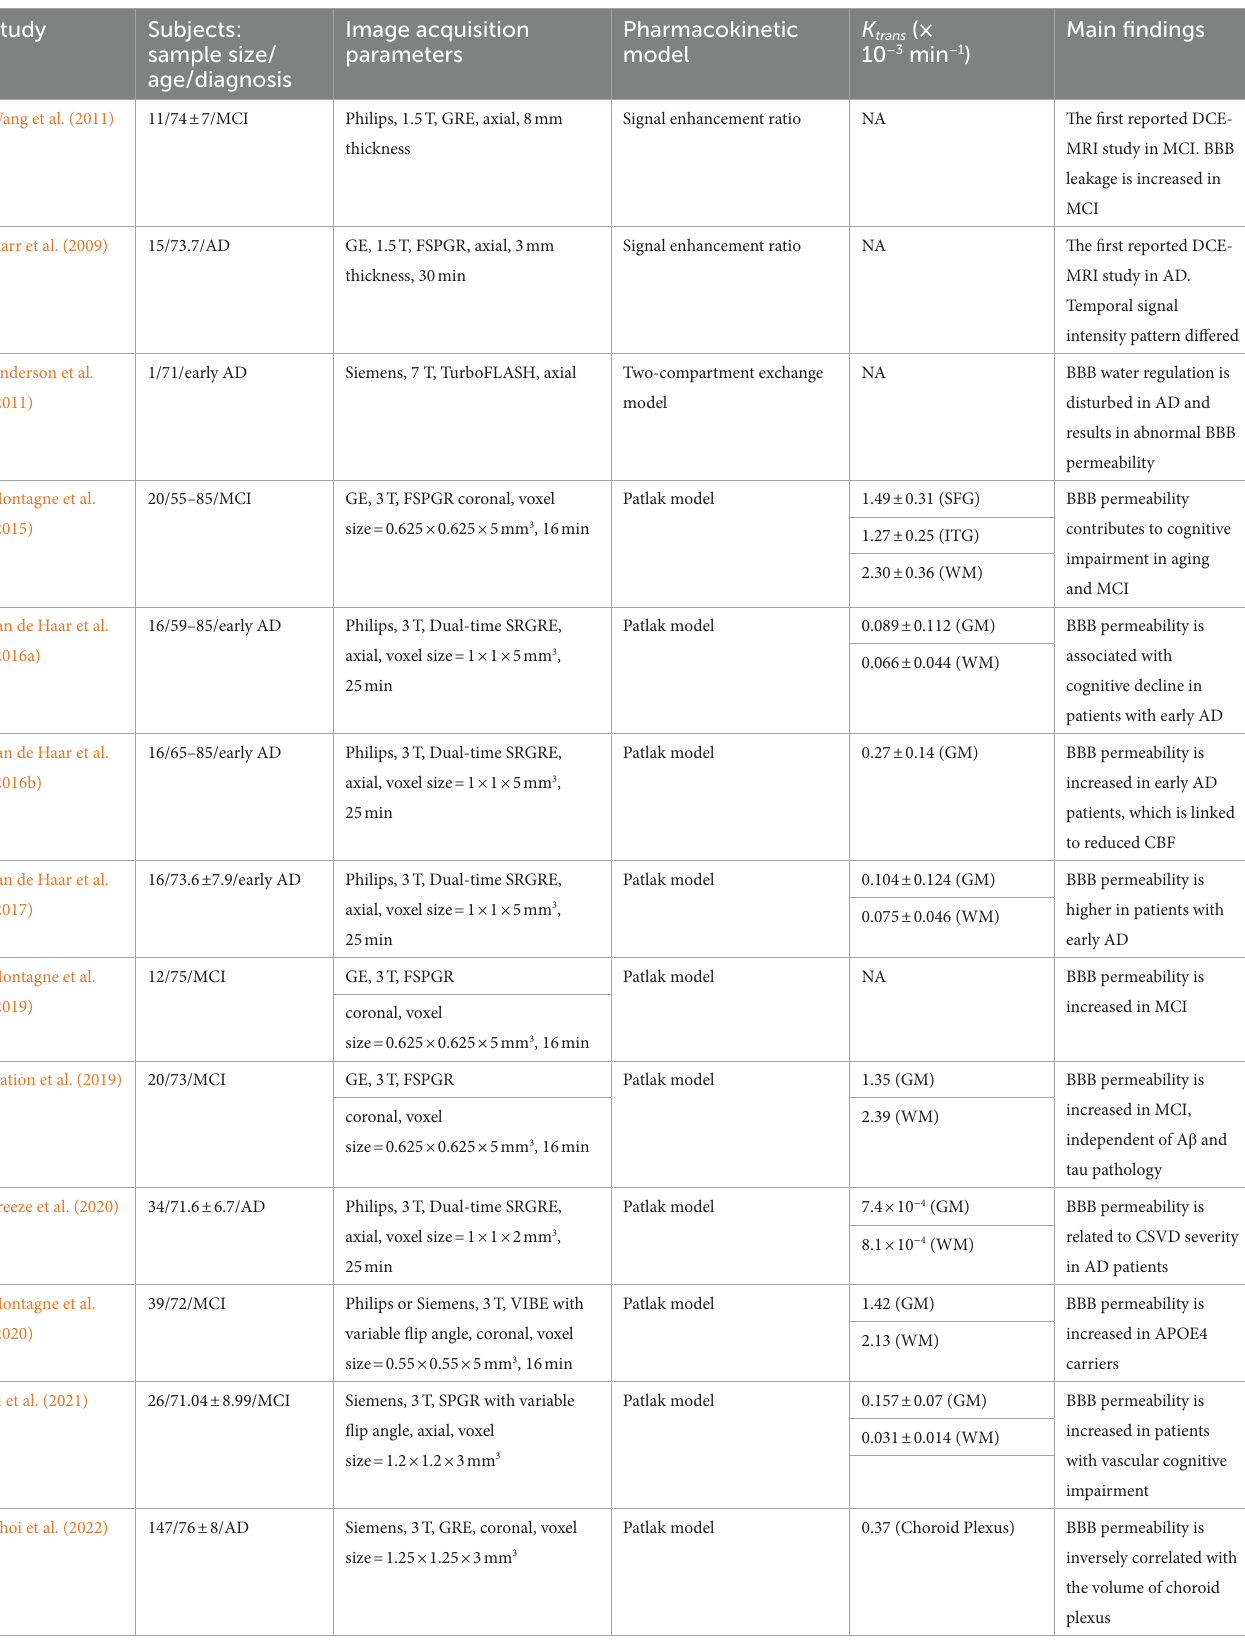
TABLE 2 Overview of DCE-MRI studies in subjects with the AD